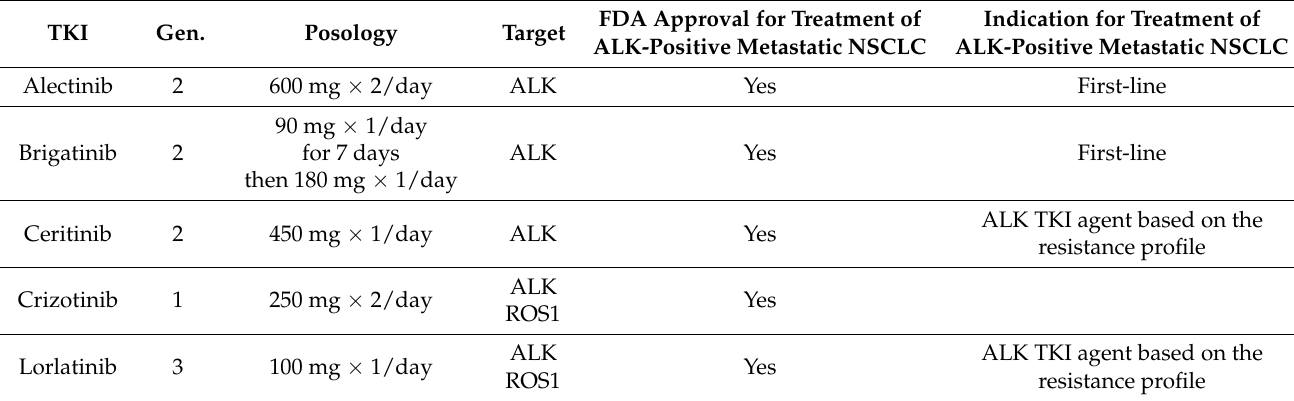
Table 2. Indication of treatment of ALK-positive metastatic small-cell lung cancer. TKI: tyrosine kinase inhibitor, ALK: anaplastic lymphoma kinase, NTRK: neurotrophic receptor tyrosine kinase, Gen.: Generation. TKI